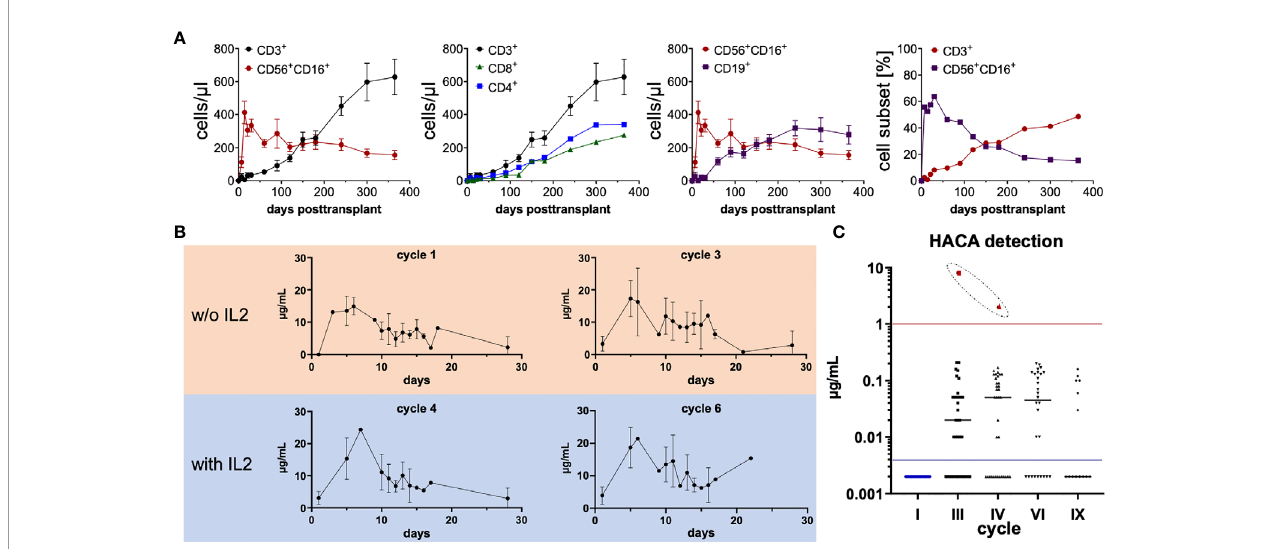
FIGURE 1 | Lymphoid immune reconstitution posttransplant, ch14.18/CHO patient serum levels as well as serum levels of human anti-chimeric antibodies (HACA). (A) Posttransplant lymphoid immune reconstitution of CD3 + T cells (CD4 + and CD8 + ), CD19 + B cells, and CD56 + CD16 + NK cells was assessed by fl ow cytometry at indicated time points. A total of n = 36 eligible patients were included in the analysis. Absolute cell counts per microliter blood (mean ± SEM) were calculated from fl ow cytometric frequencies (%) and total lymphoid cells derived from the whole blood counts of patients. In the right panel the mean frequencies [%] of CD3 + and CD56 + CD16 + are shown. (B) ch14.18/CHO patient serum levels at indicated time points during cycles 1, 3, 4, and 6 were measured by triple-ELISA as previously described (15). A minimum of one and a maximum of n = 15 in cycle 1, n = 14 in cycle 3, n = 12 in cycle 4, and n = 13 in cycle 6 serum of patients were measured. Basically in all ch14.18/CHO treatment cycles, a continuous relevant serum concentration above 1 µg/ml was sustained, facilitating a strong immunologic anti-tumor effect and consolidation by complement-dependent and cellular-dependent cytotoxicity throughout the course of antibody therapy (>6 months). (C) Neutralizing HACA antibodies were measured by ELISA as previously described (19). Only in one patient (red dots), HACAs were detected at relevant levels, indicated by the red horizontal line, in cycle 3 and cycle 4. No further data for this patient is available since no additional testing was performed in this patient afterwards. In cycle 1 n = 32, cycle 3 n = 37, cycle 4 n = 36, cycle 6 n = 28, cycle 9 n = 14 patients were evaluated. In order to display the 0 values in the logarithmic scale, 0 was substituted by 0.002 below the detection threshold (indicated by the blue horizontal